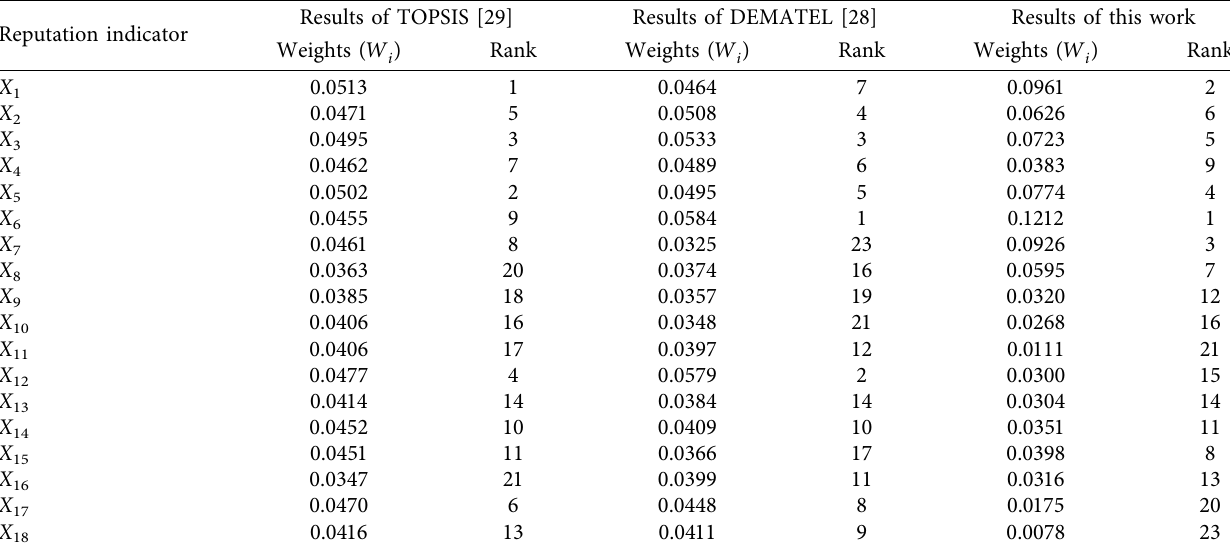
Figure 3: The degree of impact of each indicator on reputation evaluation value of PF9. Table 20: Fuzzy importance weights and ranking of reputation indicators, as obtained by TOPSIS, DEMATEL, and